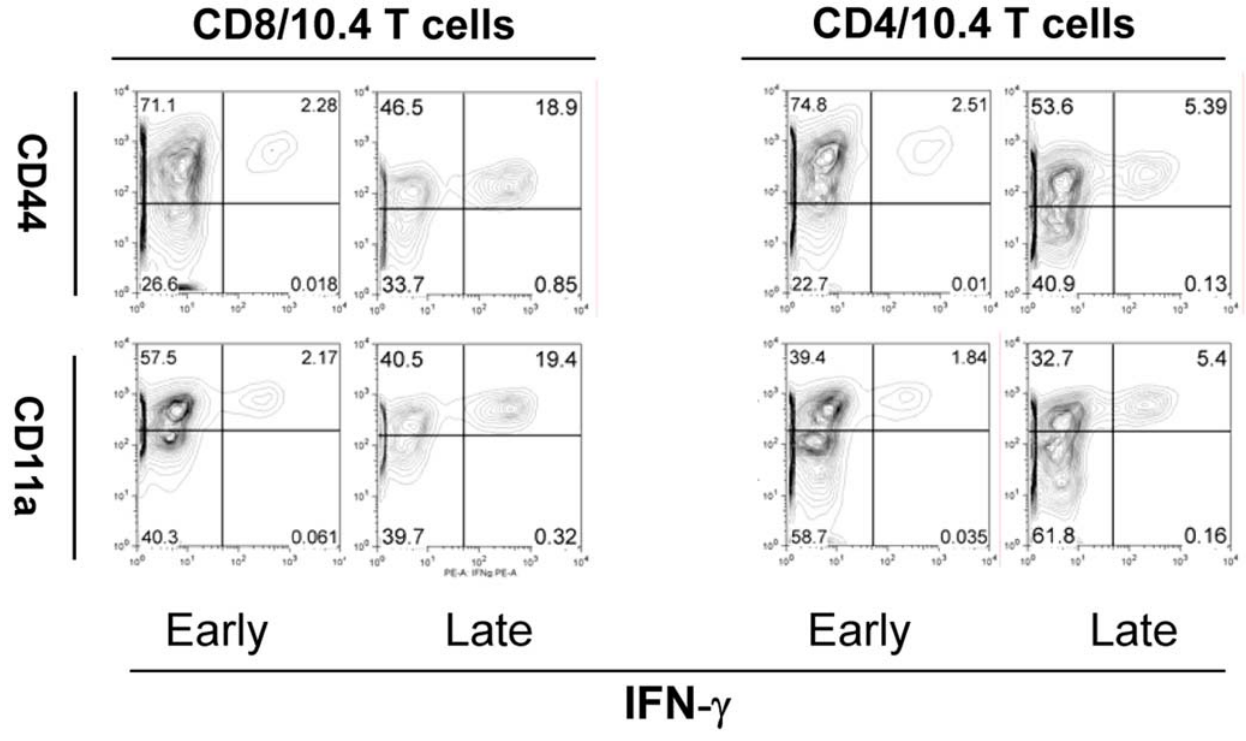
Figure 4. Phenotypic analysis of CD4/10.4 and CD8/10.4 during a persistent infection. Lung lymphocytes from mice sacrificed at different stages of infection (Early: week 6; late: week 40) were stimulated with (A) TB10.4 3–11 or (B) TB10.4 74–88 prior to staining for the surface markers CD44, CD11a and intracellularly for IFN- c . Samples were then examined by flow cytometry. FACS plots are shown for one mouse, representative of 3–4 mice.